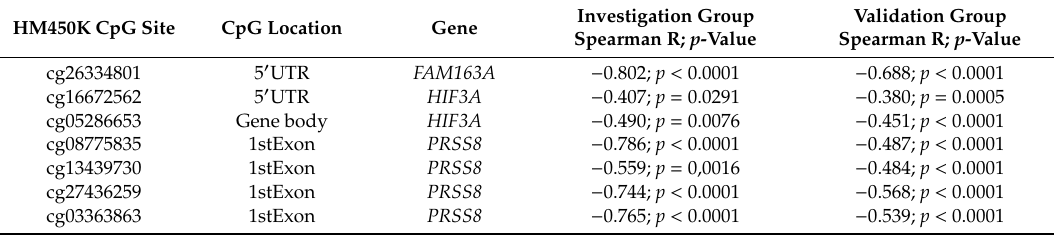
Table 2. Comparison of the results of DNA methylation / gene expression correlation analysis from the study that used HM450K data and NGS-based transcriptomic profile (investigation group) and the validation study performed by pyrosequencing and qRT-PCR (validation